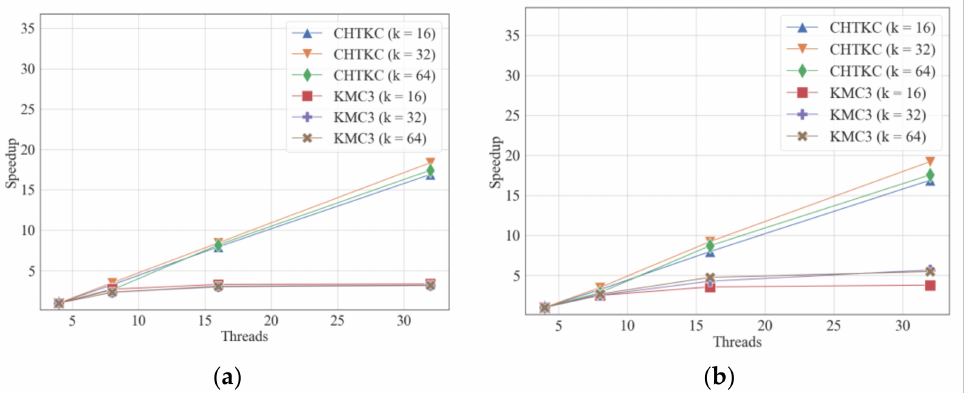
Figure 7. Strong scalability comparison of KMC3 and CHTKC. ( a ) counting k-mers with various lengths in H.1; ( b ) counting k-mers with various lengths in